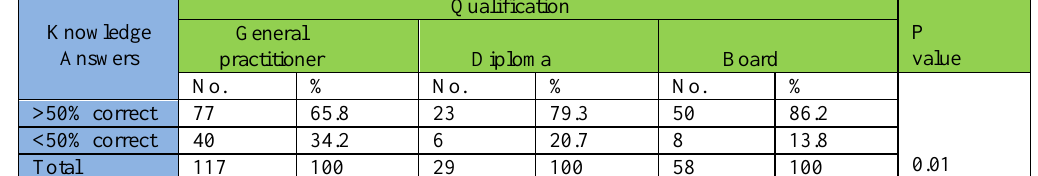
Table.3 Relationships between Knowledge Category and Qualification